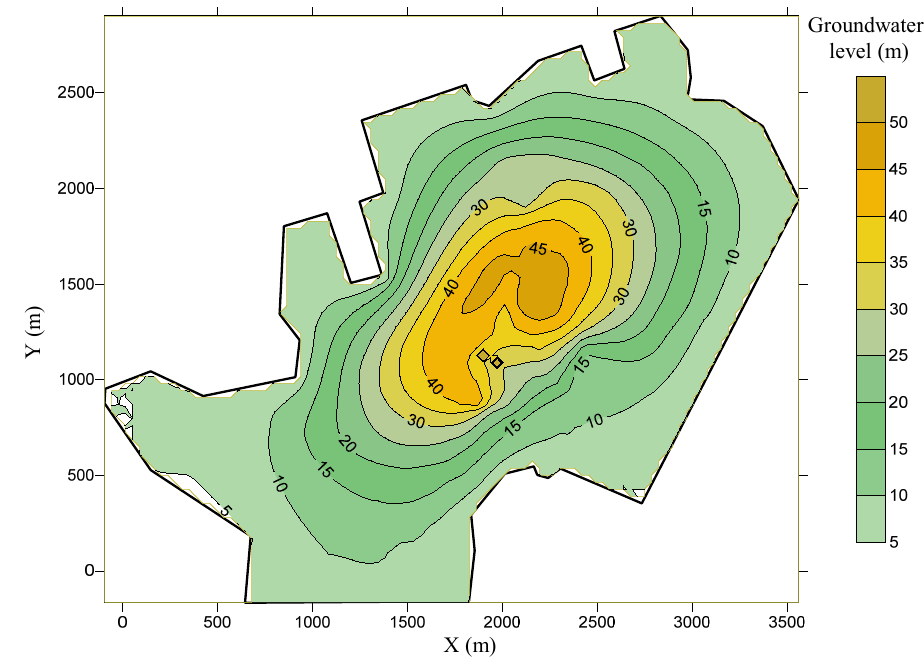
Figure 10. Groundwater level after cavern bottom excavation.